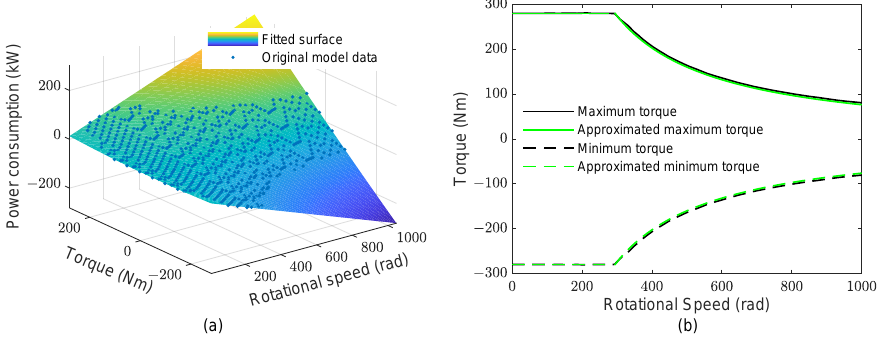
Figure 3. Power consumption and torque bounds of the motor. ( a ) Power consumption: measure- ments are represented by dots and the fitted polynomial by a surface; ( b ) Torque bounds of the motor, where the maximum and minimum torques of the motor are depicted by solid and dashed lines,